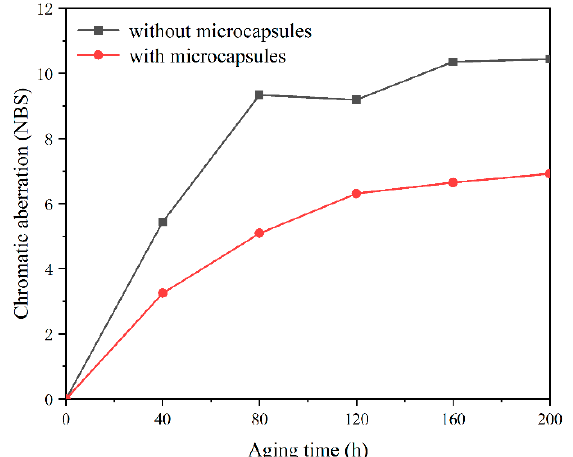
Figure 7. Influence of time on chromatic aberration of coating under 160 °C aging test.